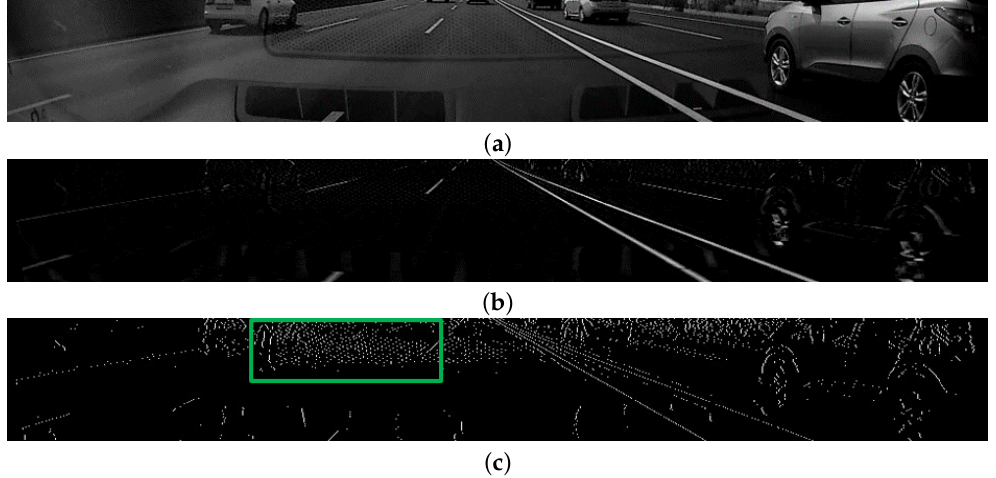
Figure 4. Examples for lane-marking feature points extraction: ( a ) ROI image; ( b ) normalized lane-marking scores image; and ( c ) lane-marking feature points